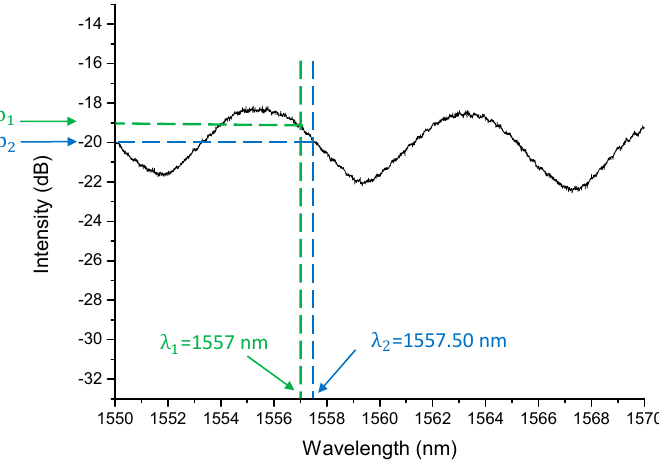
Figure 5. The spectrum of the V20161202TEST2FP fiber sensor.